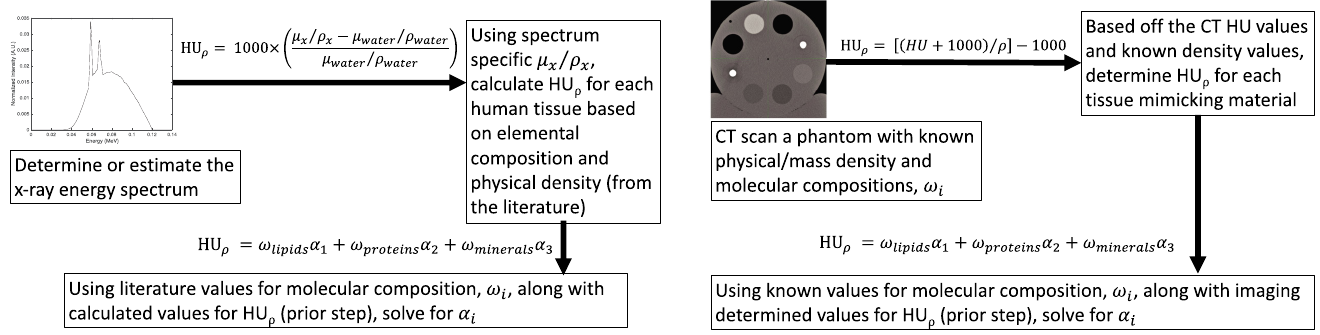
Fig 2. Workflow for the two proposed methods to determine values for α i parameters needed to calculate HU ρ . In method 1 (left), an energy spectrum must be explicitly determined a priori whereas in method 2 (right) these parameters are obtained by imaging a phantom.